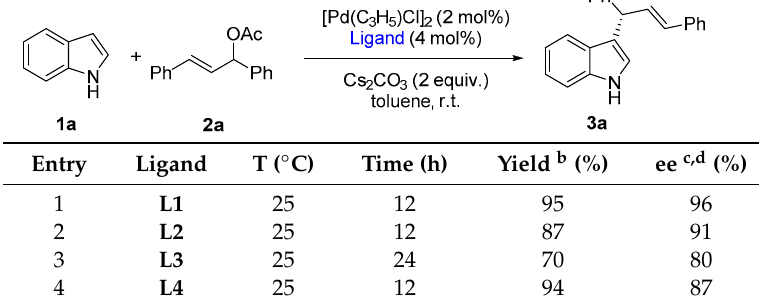
Molecules 2019 , 24 , x 3 of 16 palladium-catalyzed asymmetric allylic alkylation of indole. The reaction of indole ( 1a ) with 1,3-diphenyl-2-propenyl acetate ( 2a ) as the model reaction was examined in the presence of